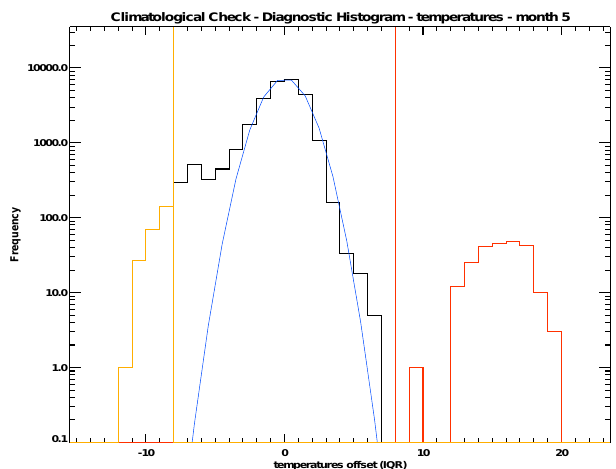
Fig. 10. Climatological outlier check (test 9) for 040180-16201 (Keflavik, Iceland, 63.97 ◦ N, 22.6 ◦ W, 50m) for temperature show- ing the distribution for May. Note logarithmic y-axis. The threshold values are shown by the vertical lines. The right-hand side shows the flagged values which occur further from the centre of the dis- tribution than the gap and the threshold value. The left-hand side shows observations which have been tentatively flagged, as they are only further from the centre of the distribution than the threshold value. It is therefore not clear if the large tail is real or an artefact.